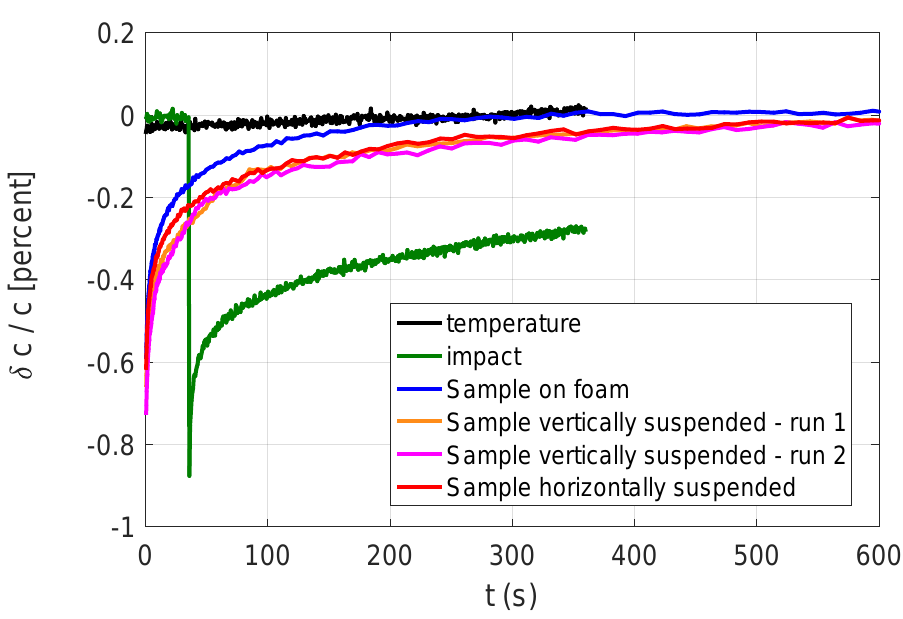
Figure A1. Linearity of the experimental set up and independence of the results from the conditioning procedure. Data for the Alu-C20